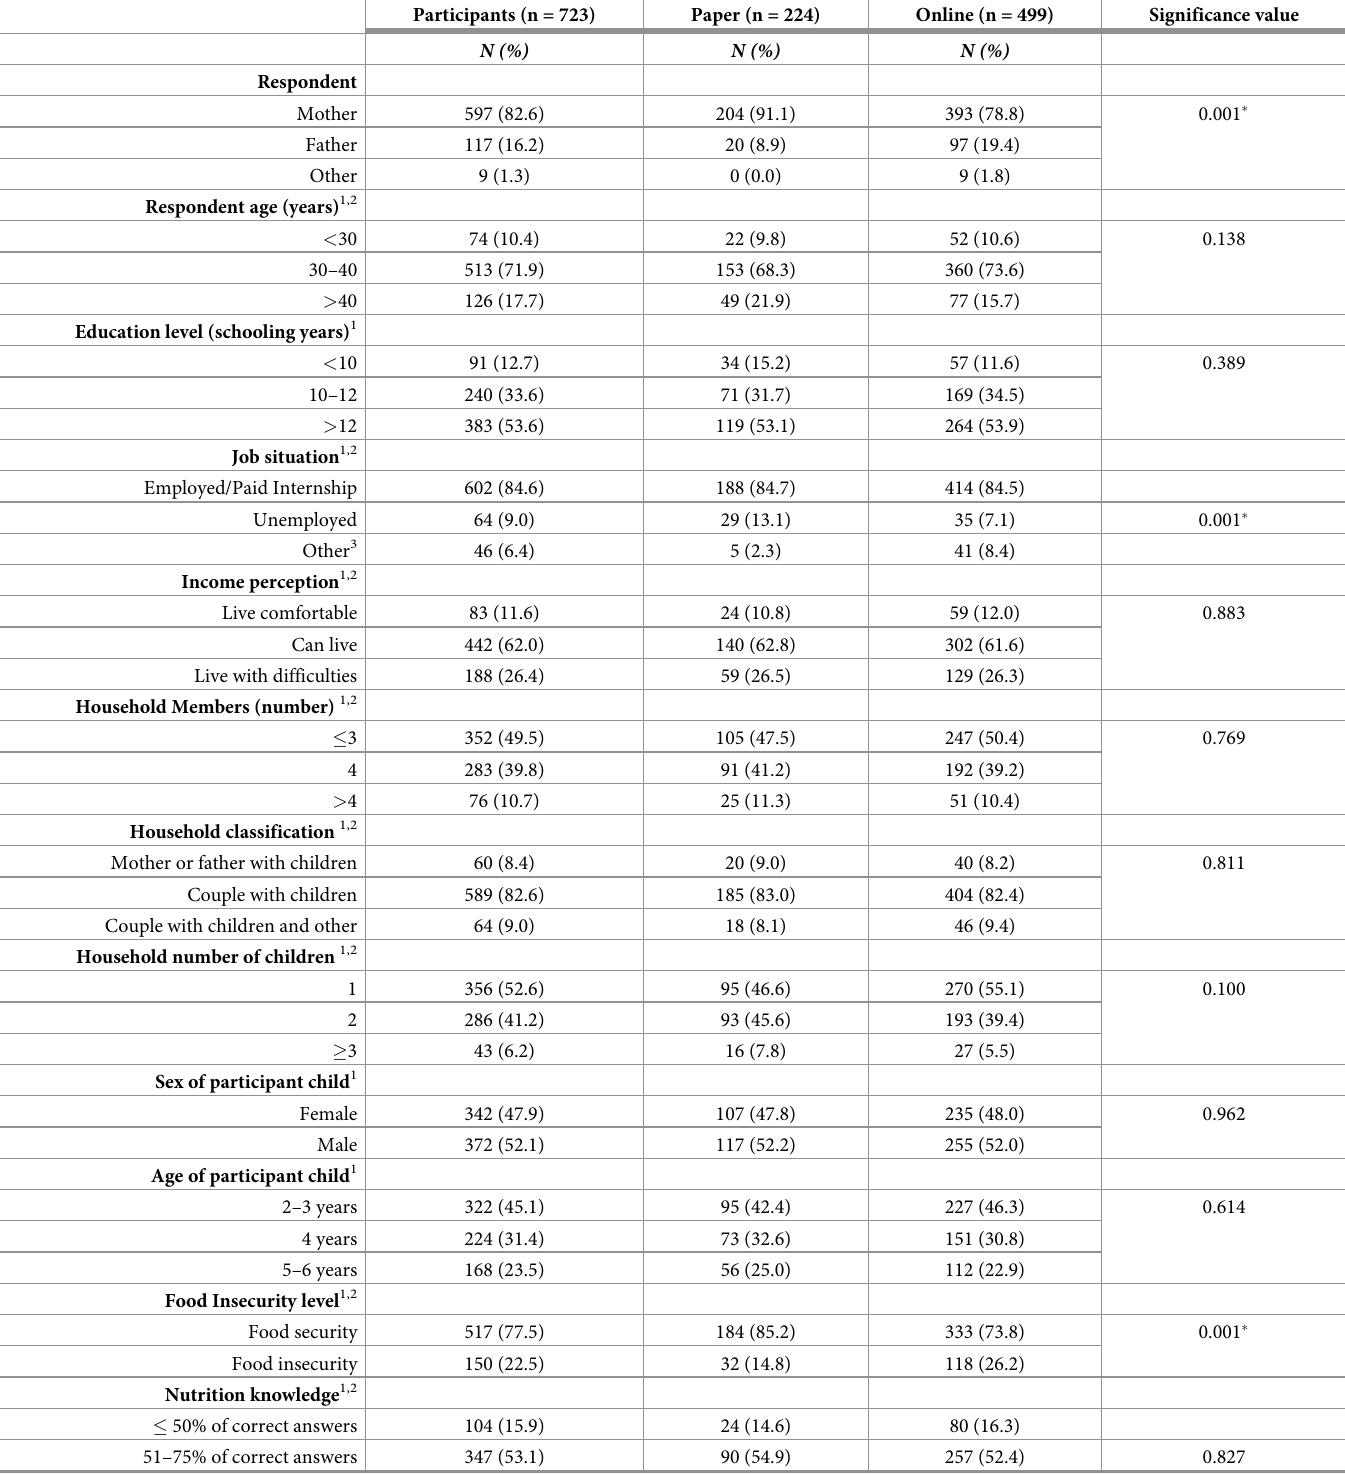
Table 1. Socio-demographic characteristics and nutrition knowledge of